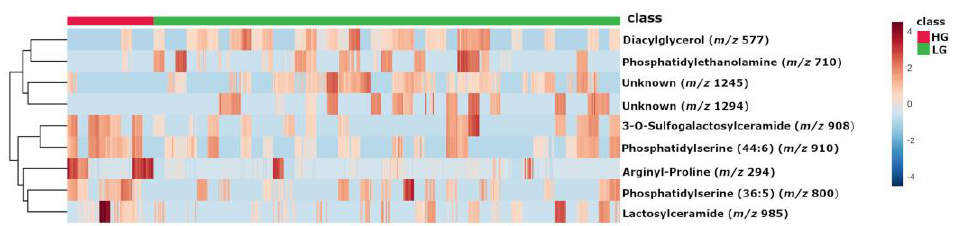
Figure 2. Volcano plot and statistical analysis of the detected metabolites. The m/z values of metab- olites with p < 0.05; fold change (FC) ≥ 1.5; Log 2 (FC) ≥ 0.585 were selected (pink dots). The gray dots correspond to m/z values that does not fit in p and FC threshold values.